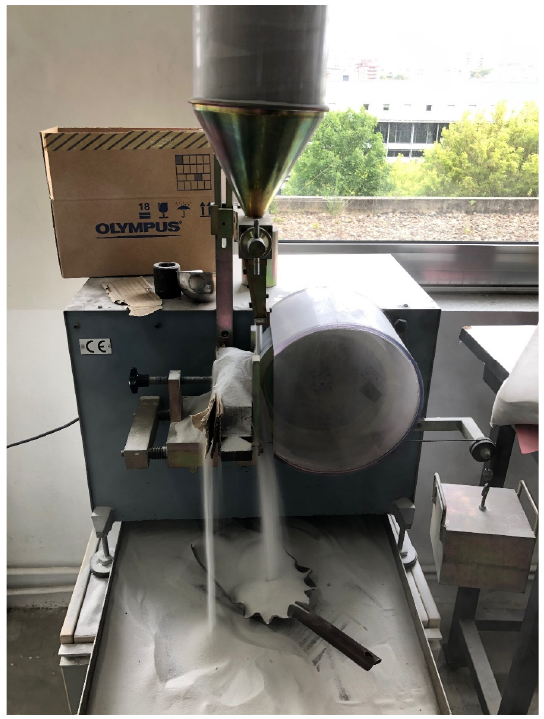
Figure 4. Set up of the abrasion wear resistance test.